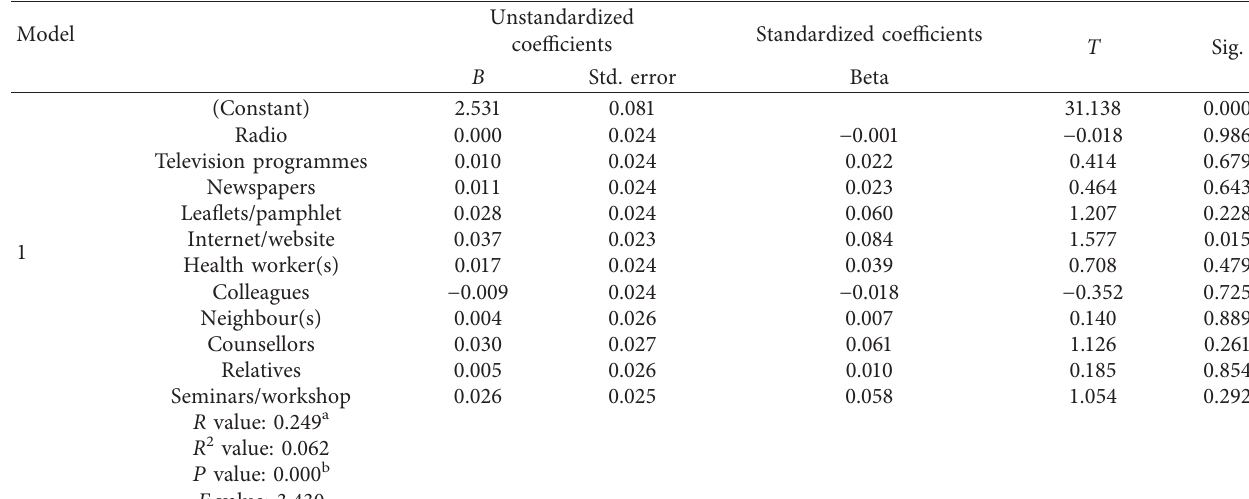
Table 4: Health communication channels and attitude of residents on hepatitis B virus.